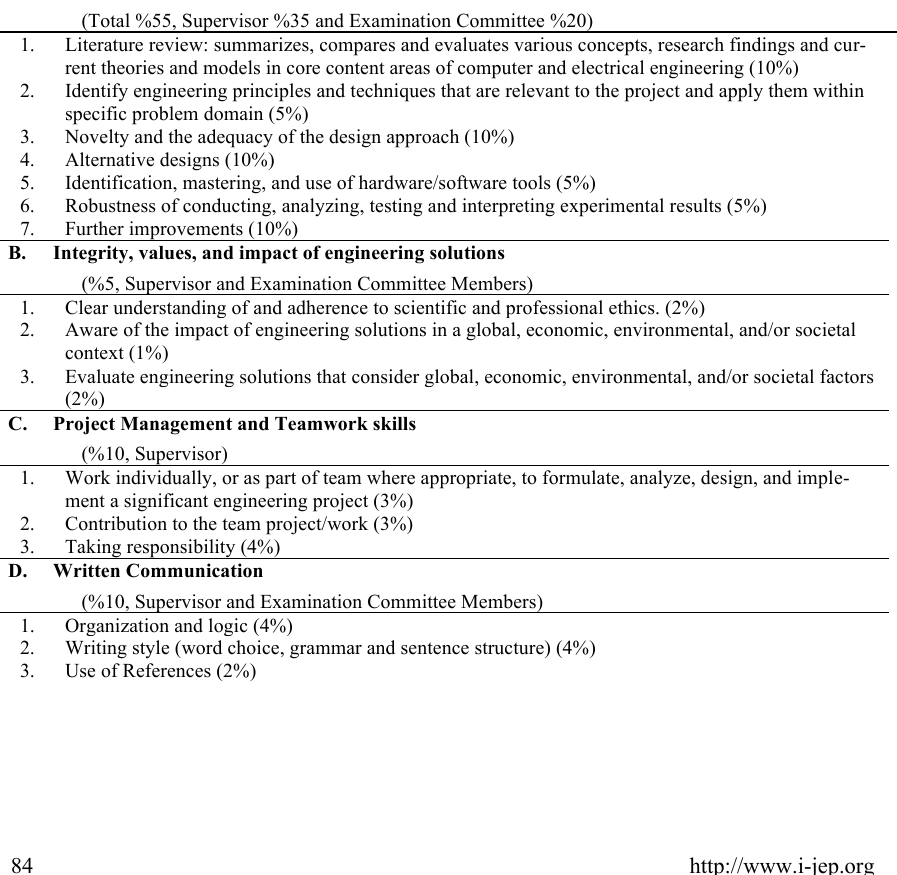
Table 5. Developed criteria, key indicators, and weights per criterion and indicators